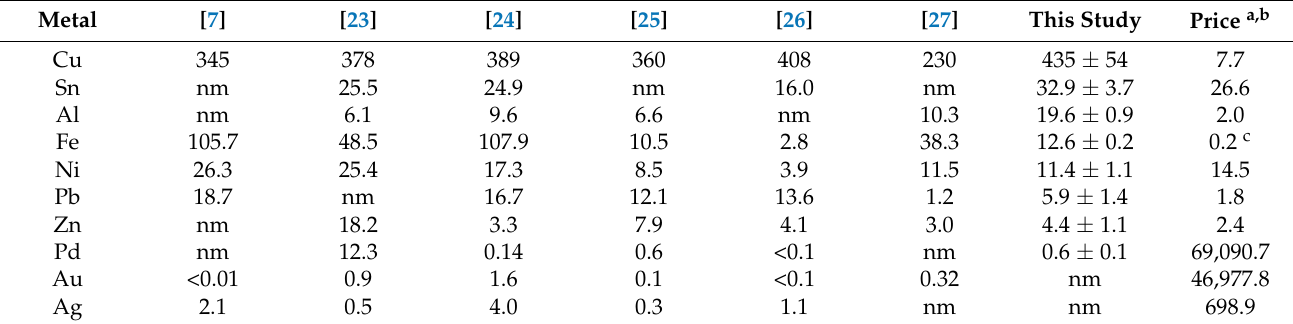
Figure 1. ( a ) Manual dismantling of mobile phones and ( b ) recovered PCBs.